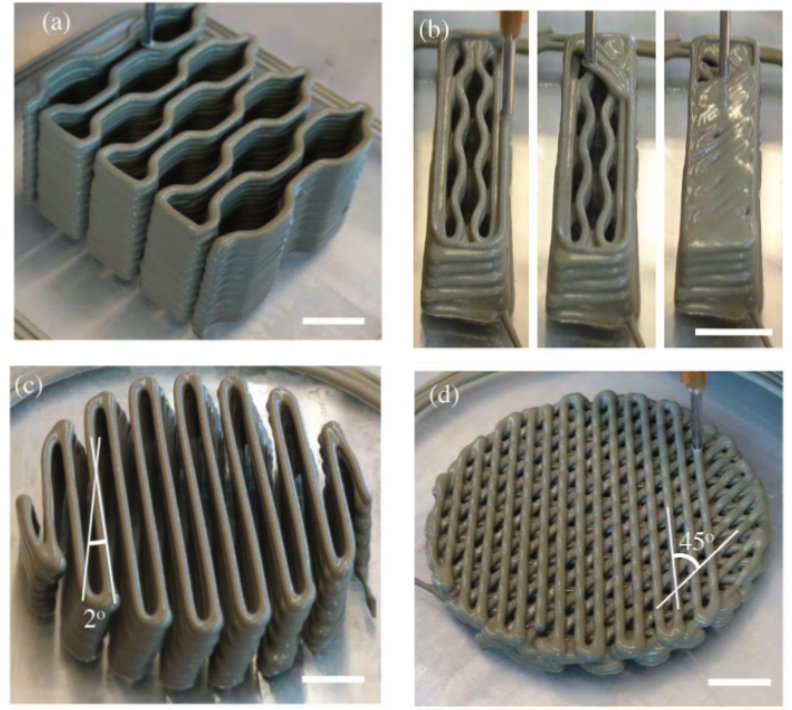
Figure 2. ( a ) Honeycomb; ( b ) cellular panel; ( c ) Bouligand shape (2°); ( d ) Bouligand shape (45°) [26].